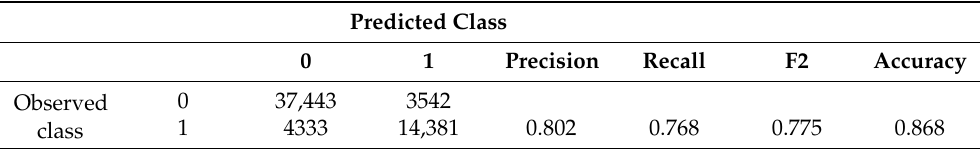
Table 4. Confusion matrix for RF-US model with the test set.